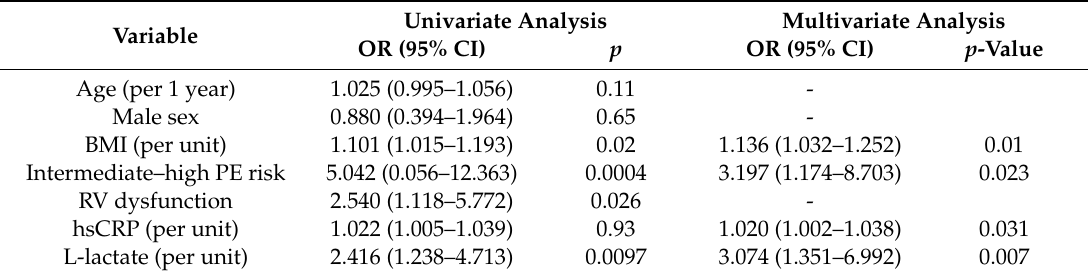
Table 3. Determinants of prolonged CLT defined as values > 121.5 min (top quartile) in patients with acute pulmonary